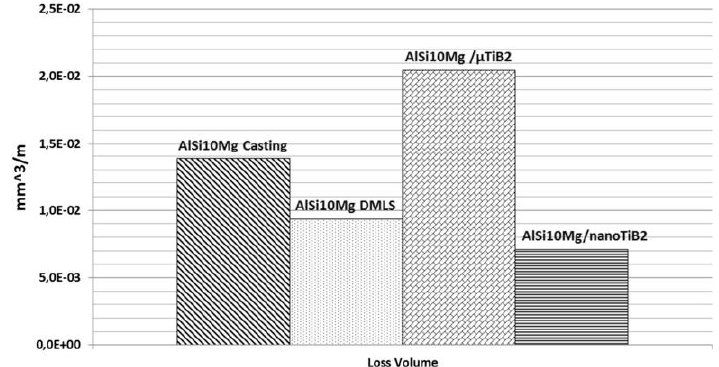
Figure 15. Volume per meter loss after wear tests of the AlSi10Mg samples obtained by casting and DMLS, and of the composites with micro- and nano TiB 2 particles. Reproduced from [43], with permission from Springer Nature, 2016.